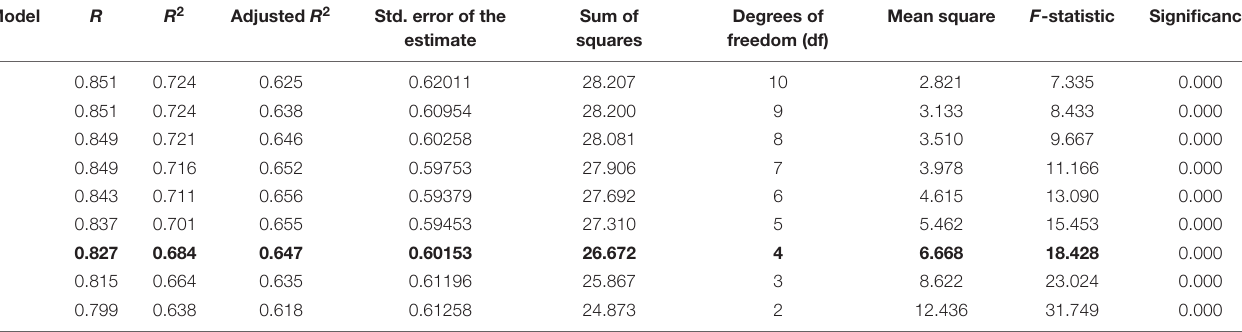
TABLE 5 | Model summary for the backward stepwise linear regression on the physical fitness change scores from Grade 6 to Grade 9, with the inclusion of MVPA OB . Model